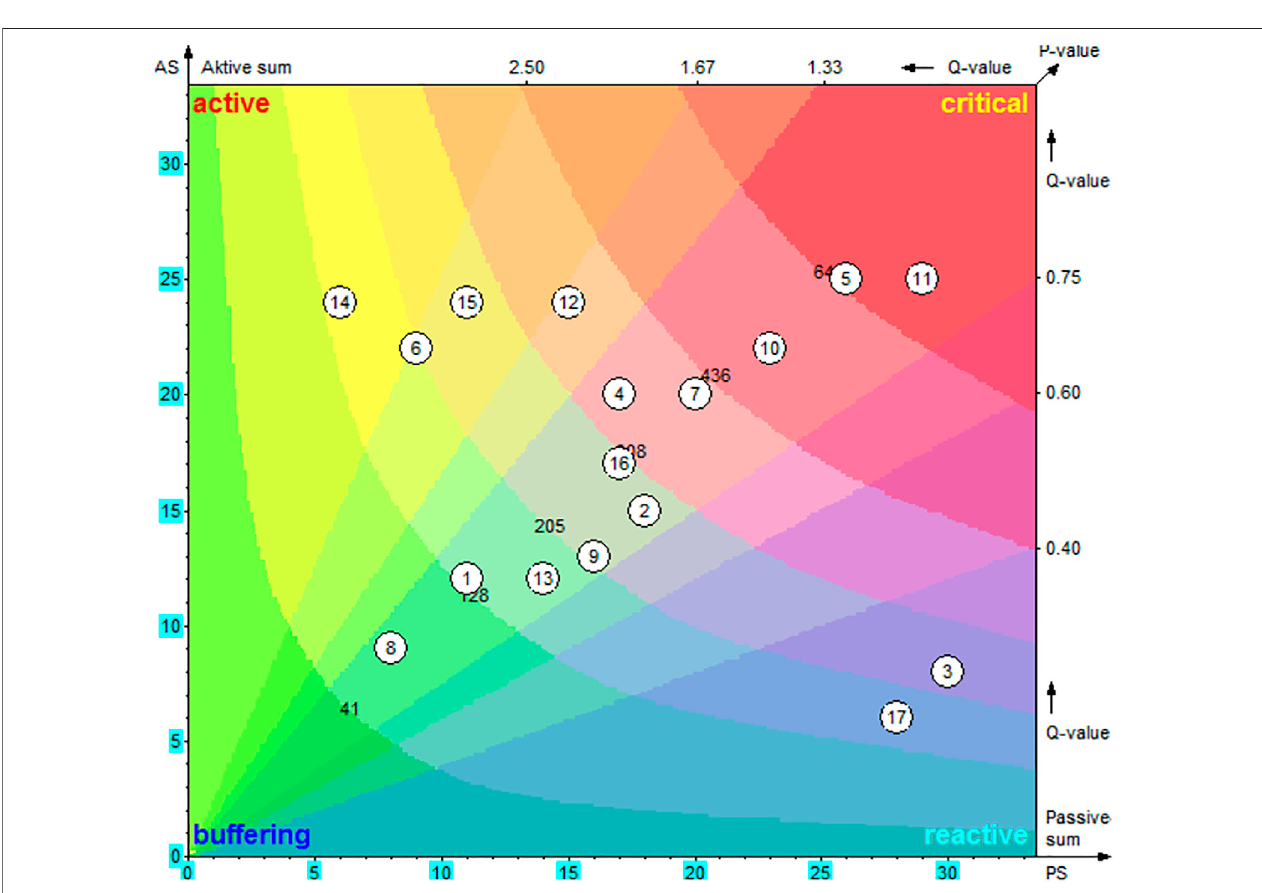
FIGURE 4 | Role played by the variable.